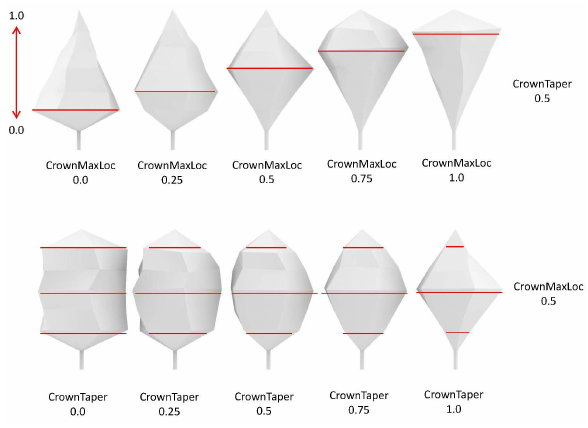
Figure 3. CrownMaxLoc and CrownTaper parameters affect the crown shape.